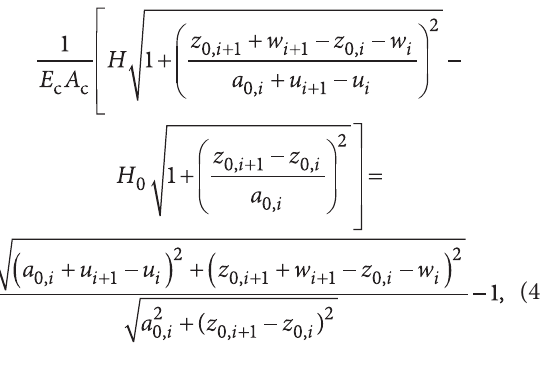
Fig. 2. Final discrete scheme of the cable (Idnurm